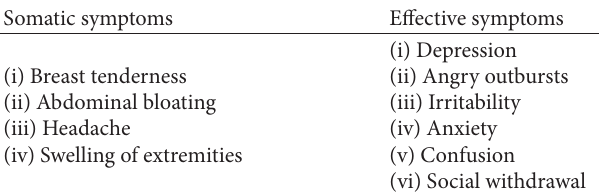
Table1:GroupofsymptomsaccordingtoACOGdiagnosticcriteria. Somatic